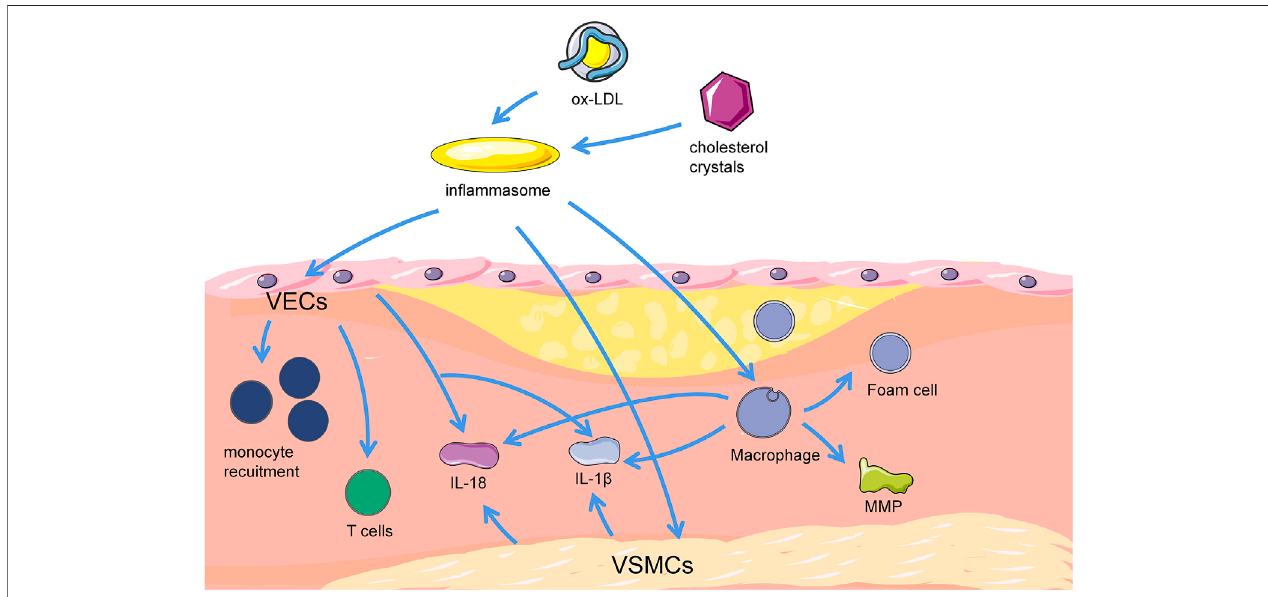
FIGURE 1 | Correlation between pyroptosis and progression of atherosclerotic plaques. Cholesterol crystal, and ox-LDL can activate in fl ammasomes in ECs, macrophages and VSMCs, trigger cellular pyroptosis and stimulate AS. Pyroptotic ECs can mediate T cell migration to the inner membrane and promote monocyte recruitment. Furthermore, pyroptotic ECs release proin fl ammatory cytokines, such as IL-18 and IL-1 β , and result in vascular in fl ammation. Macrophages uptake cholesterol crystals and turn into lipid containing foam cells subsequently. Macrophage pyroptosis mediate the production of pro-in fl ammatory mediators and cytokines, including MMP, IL-18, and IL-1 β . These pro-in fl ammatory mediators and cytokines also trigger foam cell pyroptosis, thereby forming the necrotic core of plaques in advanced lesions. Pyroptotic VSMCs release pro-in fl ammatory cytokines like IL-18 and IL-1 β , and attenuate stability of fi brous caps via loss of collagen and matrix, causing in fl ammation, promoting plaque instability or erosion, and potentially worse AS. VSMCs, vascular smooth muscle cells. VECs, vascular endothelial cells. MMP, matrix metalloproteinase. IL-18, interleukin-18. IL-1 β , interleukin-1 β